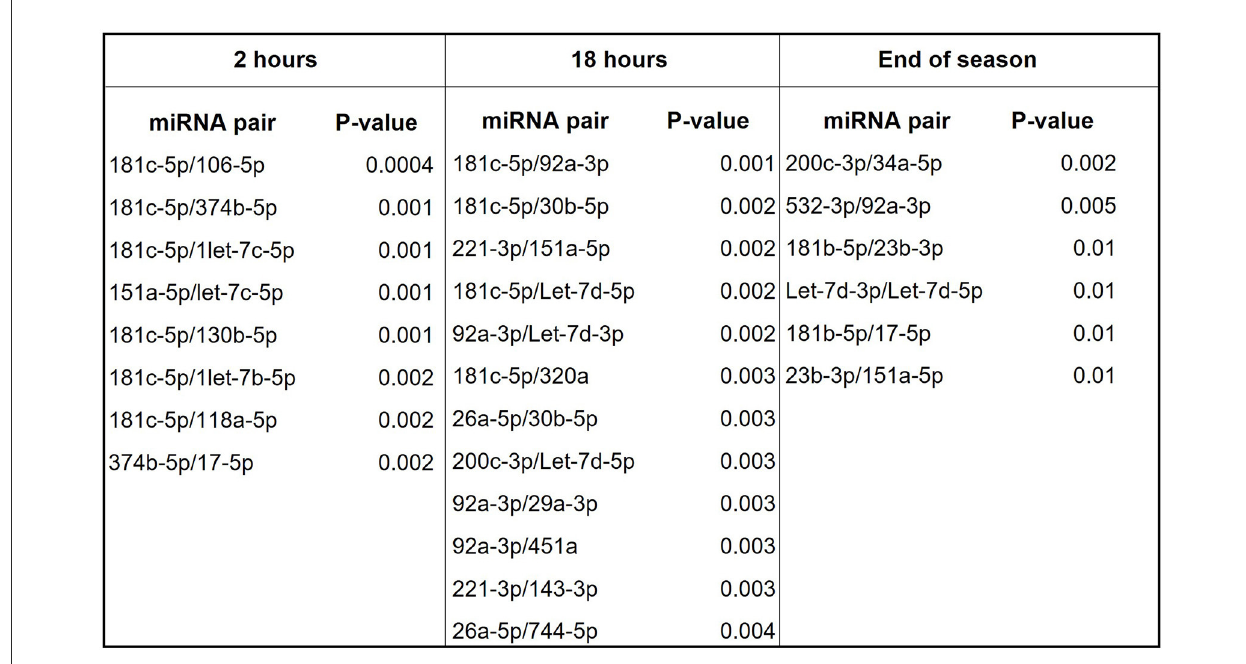
FIGURE5 miRNA pairs discriminating concussed players from controls at various points during game season. List of miRNA pairs that best discriminate concussed players from controls at the indicated timepoints.